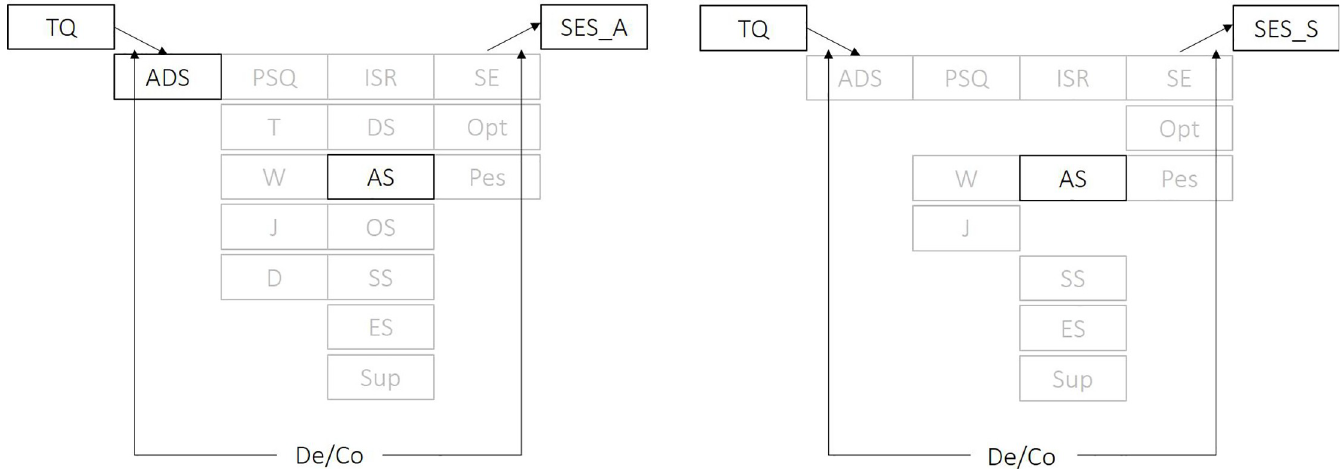
Fig 4. Graphical illustration of moderated mediation models for affective (left) and sensory pain perception (right). De/Co indicates the specification of tinnitus decompensation vs. compensation as a putative moderator of the indirect effects of tinnitus-related distress on affective or sensory pain perceptions through the specified process variables. Continuous black box frames indicate that respective indirect effects are stronger in patients with decompensated vs. compensated tinnitus. Greyed out boxes indicate non-moderated indirect effects. TQ = Tinnitus Questionnaire–German version total score, SES_A = Affective Pain Perception Scale: SES_S = Sensory Pain Perception Scale, ADS = Center for Epidemiological Studies Depression Scale total score, PSQ = Perceived Stress Questionnaire total score, T = tension, W = worries, J = joy, ISR = ICD-10 Symptom Rating total score, DS = depressive syndrome, AS = anxiety-related syndrome, OS = obsessive-compulsive syndrome, SS = somatoform syndrome, ES = eating-related syndrome, Sup = supplementary scale, SE = Self-efficacy scale, Opt = Optimism scale; Pes = Pessimism scale. Significance level set at p < .05.